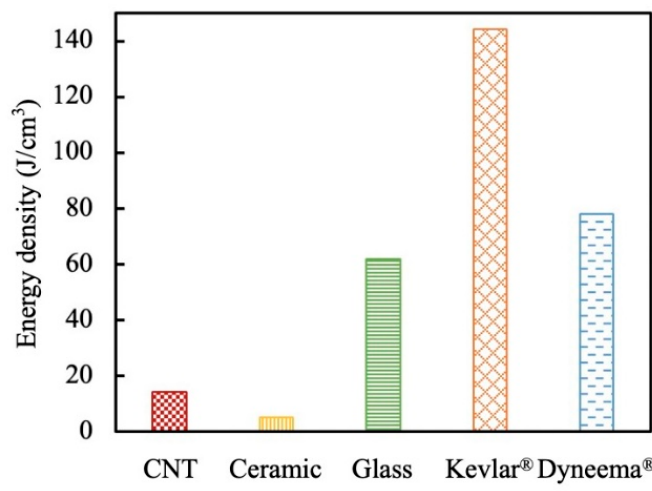
Figure 14. Comparison of energy density of different fibers.